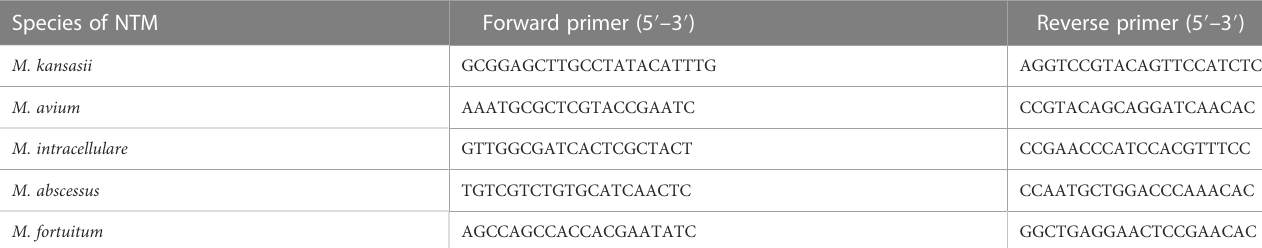
TABLE 1 The ampli fi cation primers for NTM are listed below: